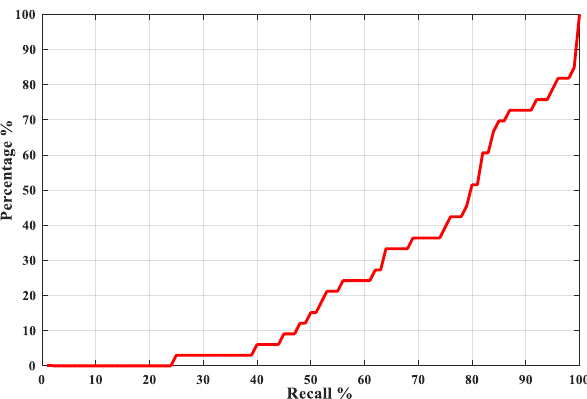
Figure 12. Recall of different ranging results.